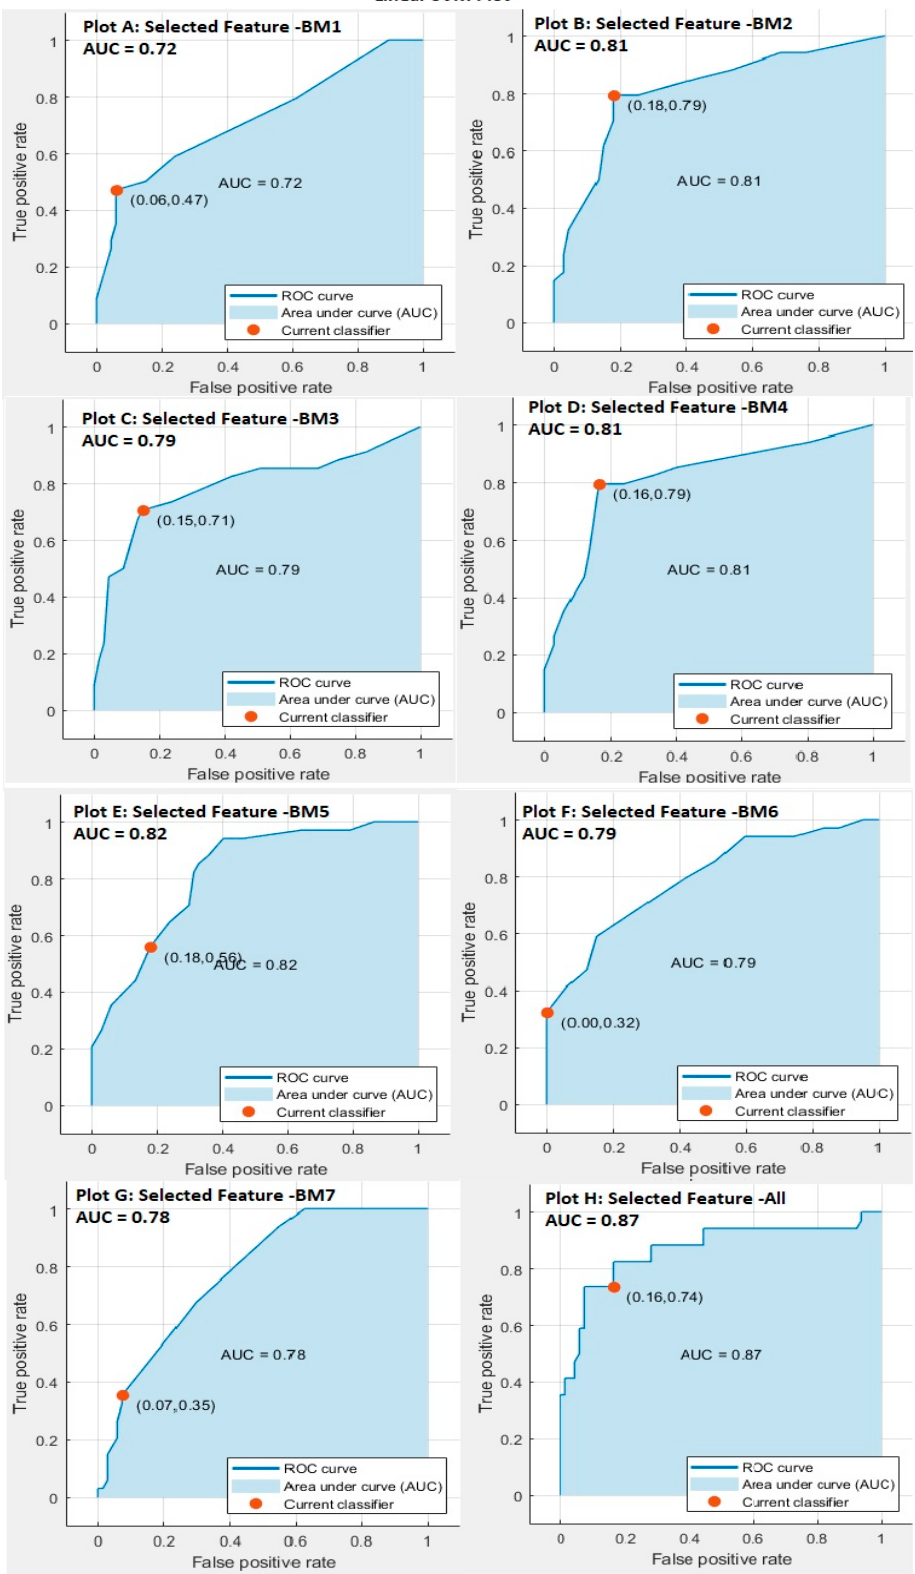
Figure 5. The ROC curves of pooled JMU and UGA dataset with selected biomimicry attributes-Plot A to G and all biomimicry attributes-Plot H.